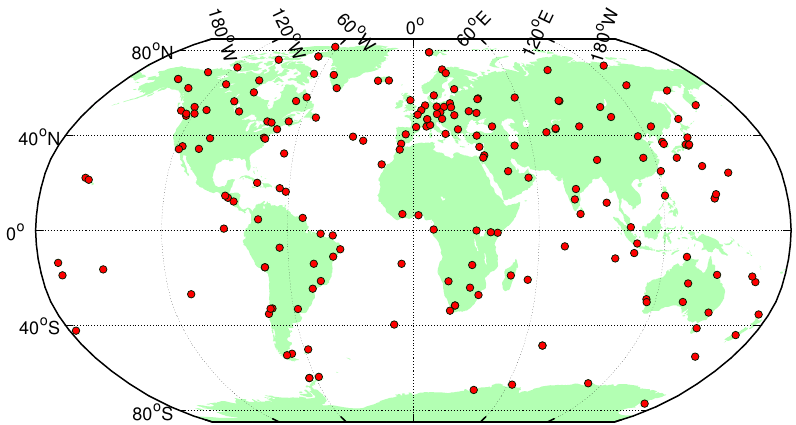
Figure 1. Distribution of the stations involved in the Helmert transformation.